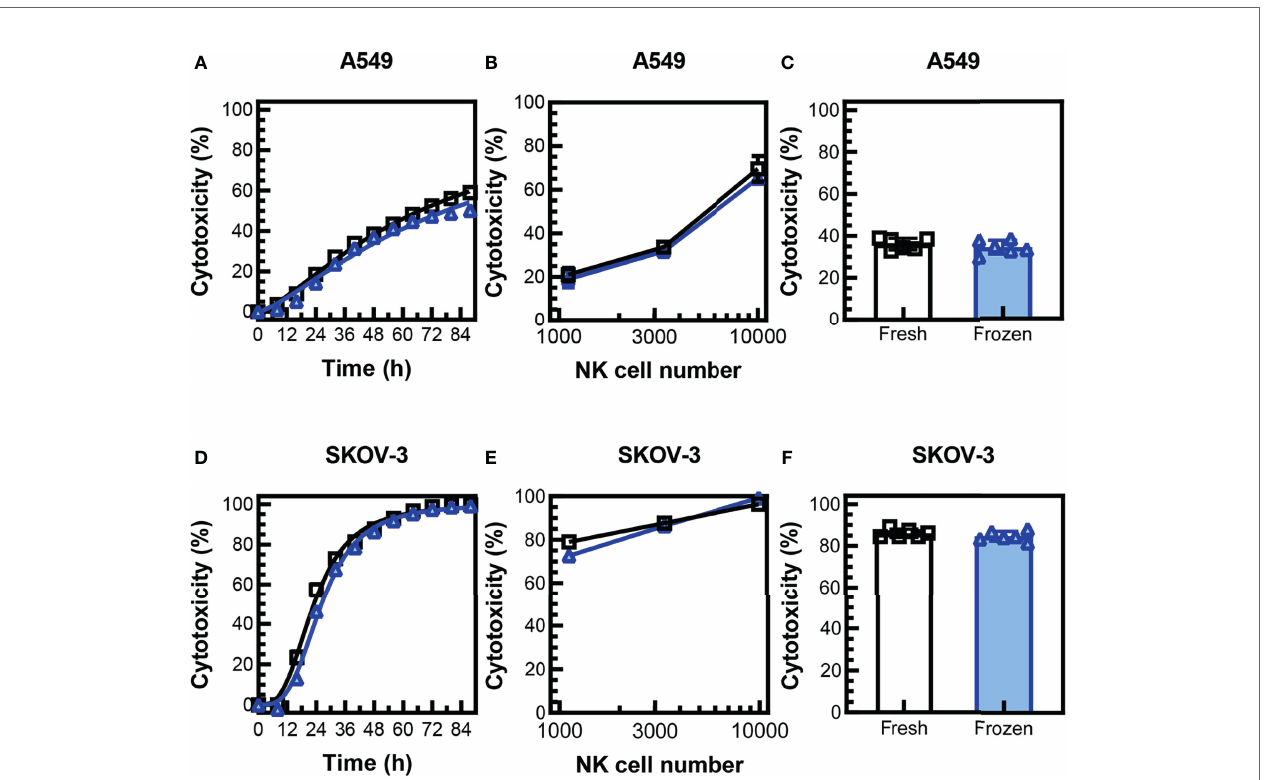
FIGURE 4 | Cryopreserved NK cells maintain cytotoxicity in 3D tumor cell spheroid models. PM21-NK cells were expanded from T-cell-depleted PBMCs obtained from two donors. Cells were cryopreserved while donor-matched fresh PM21-NK cells were maintained in culture. Frozen NK cells were thawed and rested 16 h the day before analysis. NK-cell cytotoxicity was determined by kinetic live-cell imaging assay. Cryopreserved PM21-NK cells (blue triangles) were as ef fi cacious at killing as fresh donor and expansion-matched PM21-NK cells (black squares) when 3,300 NK cells were cocultured with A549 spheroids (A) or SKOV-3 spheroids (D) (one representative donor in triplicate). Concentration-dependent cytotoxicity curves were also generated, and no signi fi cant difference between cryopreserved PM21-NK cells or fresh PM21-NK cells was found after 48 h of coculture with A549 spheroids (B) or SKOV-3 spheroids (E) (one representative donor in triplicate). Cryopreserved PM21-NK cells killed similarly A549 (C) or SKOV-3 (F) spheroids compared to matched fresh PM21-NK cells (3,300 NK/spheroid, N = 2 donors, in triplicate). Data are presented as scatter plots or bar graphs with error bars representing standard deviation. No statistical signi fi cance was determined by two-way ANOVA or multiple t- tests. For cytotoxicity time course plots, the area under the curve was measured and then statistical signi fi cance was determined by unpaired